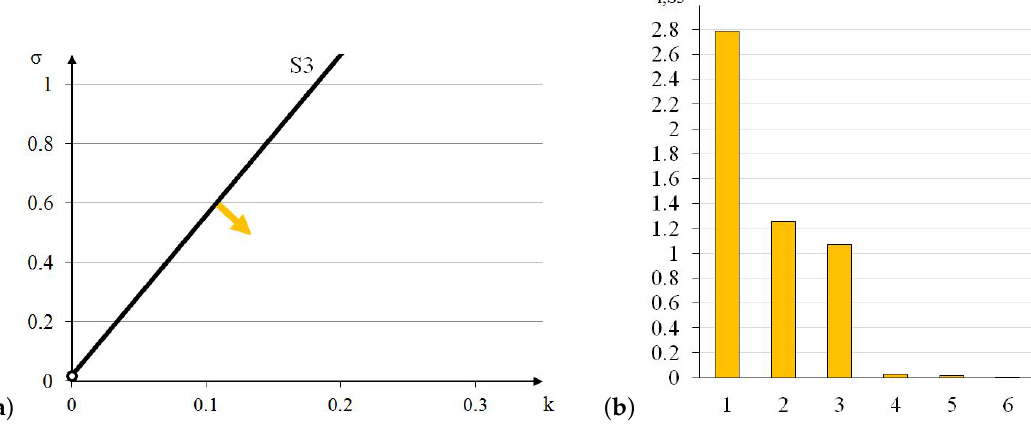
Figure 8. Extreme properties of the 3-strut simplex: ( a ) Line of extreme properties σ = 0.023 + 5.4 · k . ( b ) Distribution of eigenvalues for k = 0.1, σ = 0.563 (multiplier EA / a 2